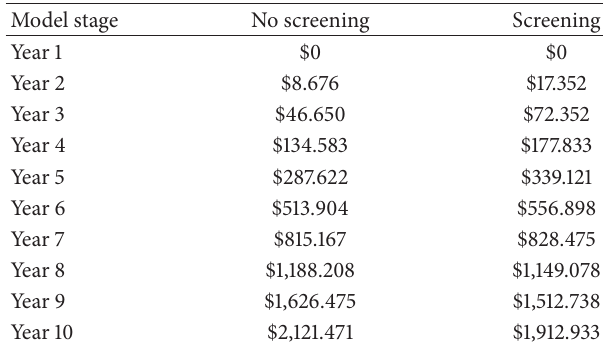
Table 2: Results of Markov model simulation of dementia care costs per